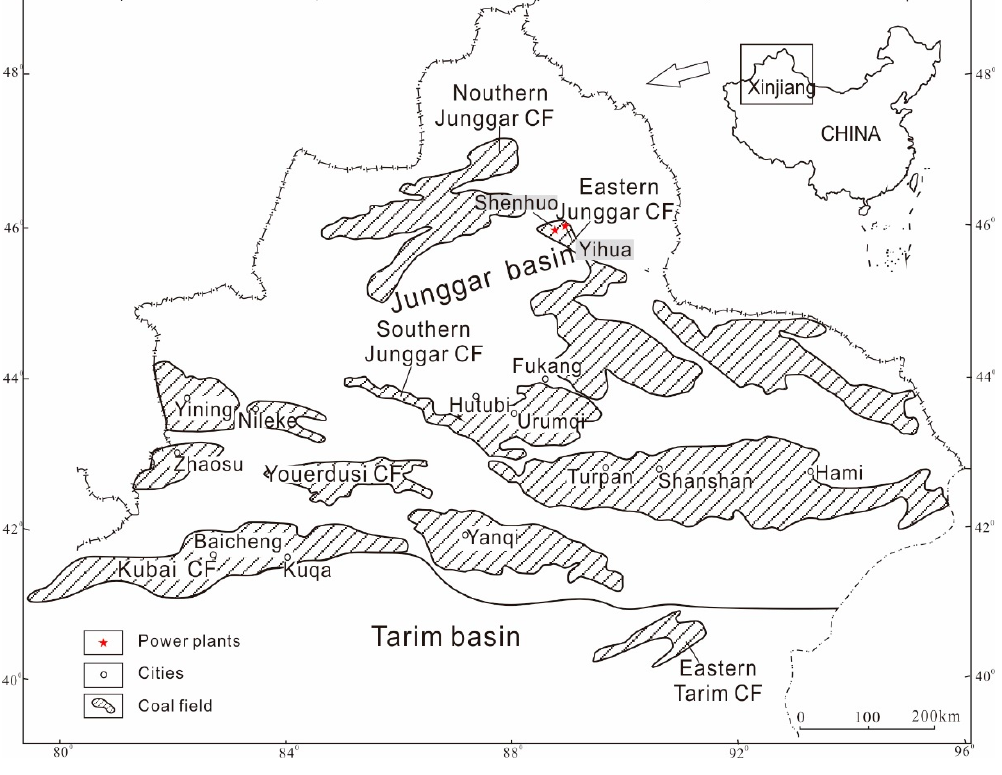
Figure 1. Location of Shenhuo and Yihua power plants (modified after Li et al., 2012) [37].